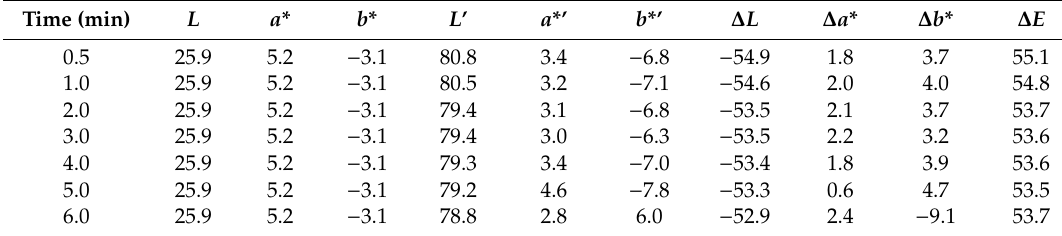
Table 6. E ff ect of drying time on color di ff erence of the